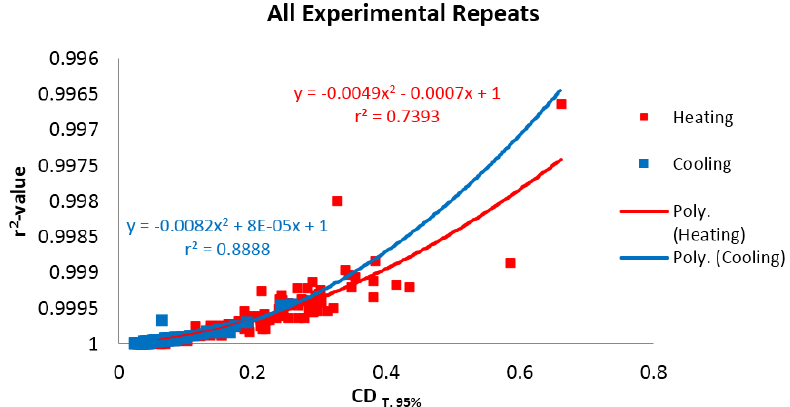
Figure 16. Comparison of heating and cooling TR repeats (relationship between r 2 -value and CD T ,95% ).